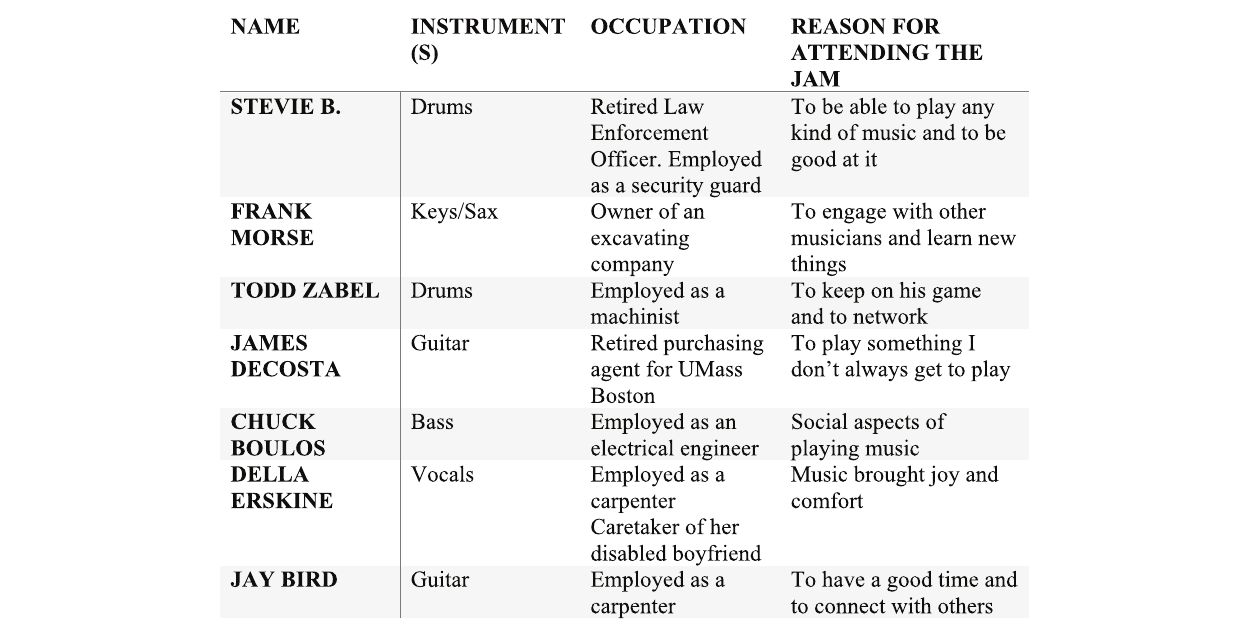
FIGURE 2 | Characteristics of the participants in the study. The participants are listed in the order they were interviewed.